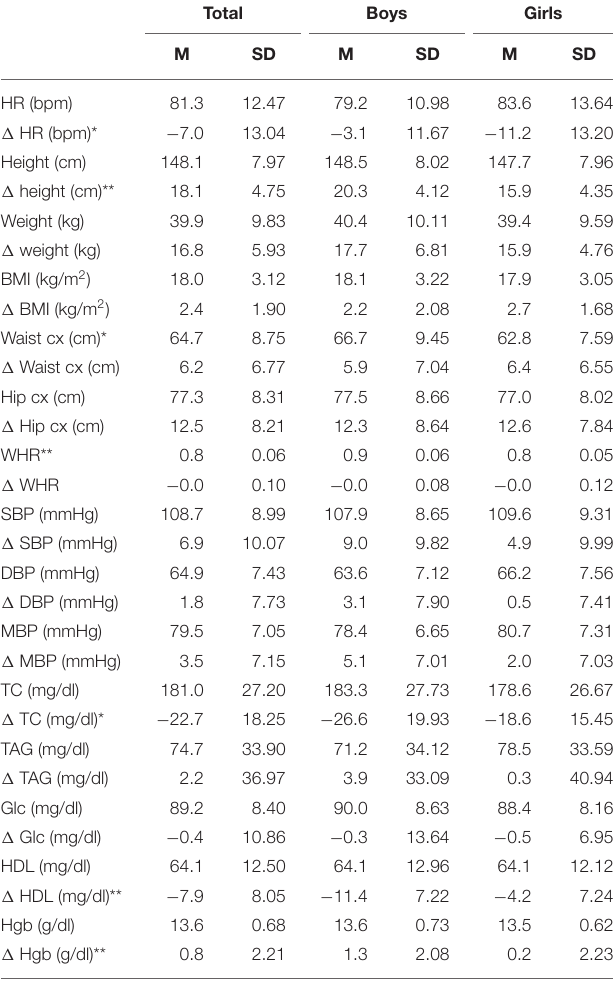
TABLE 1 | Descriptive statistics of the study population presented as mean (SD) for boys and girls